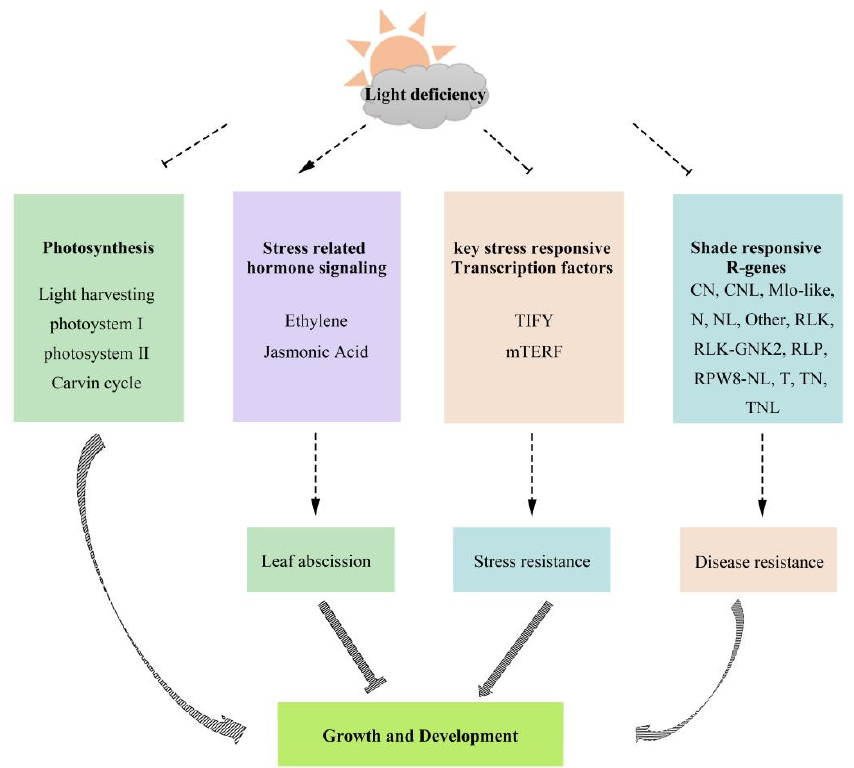
M. sinostellata . Figure 6. Hypothetical model of the light deficiency response mechanism in the endangered species M. sinostellata.